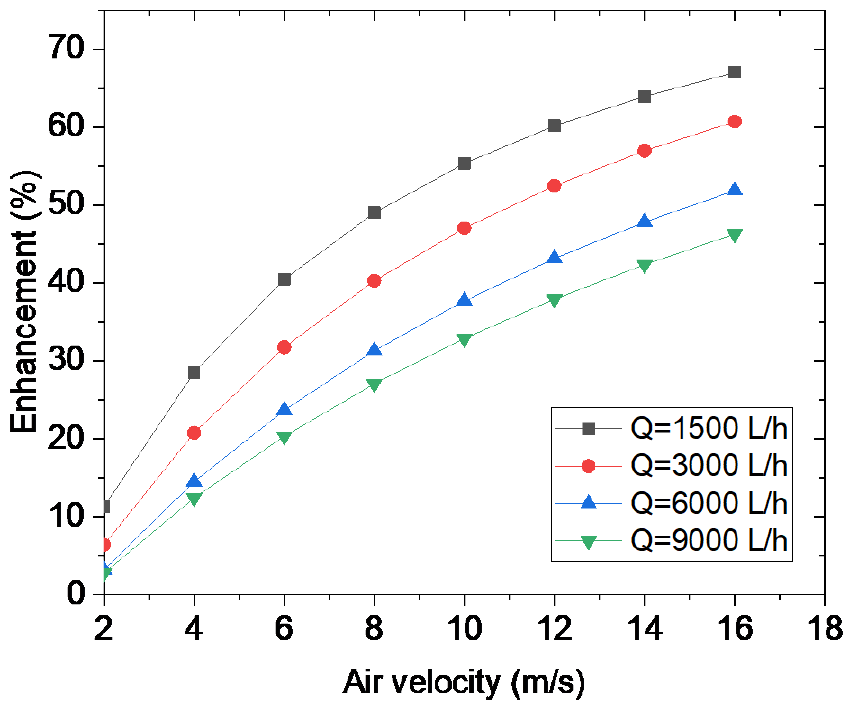
Figure 13. Variation of the HX thermal performance enhancement in function of the air velocity for different water flow rates.